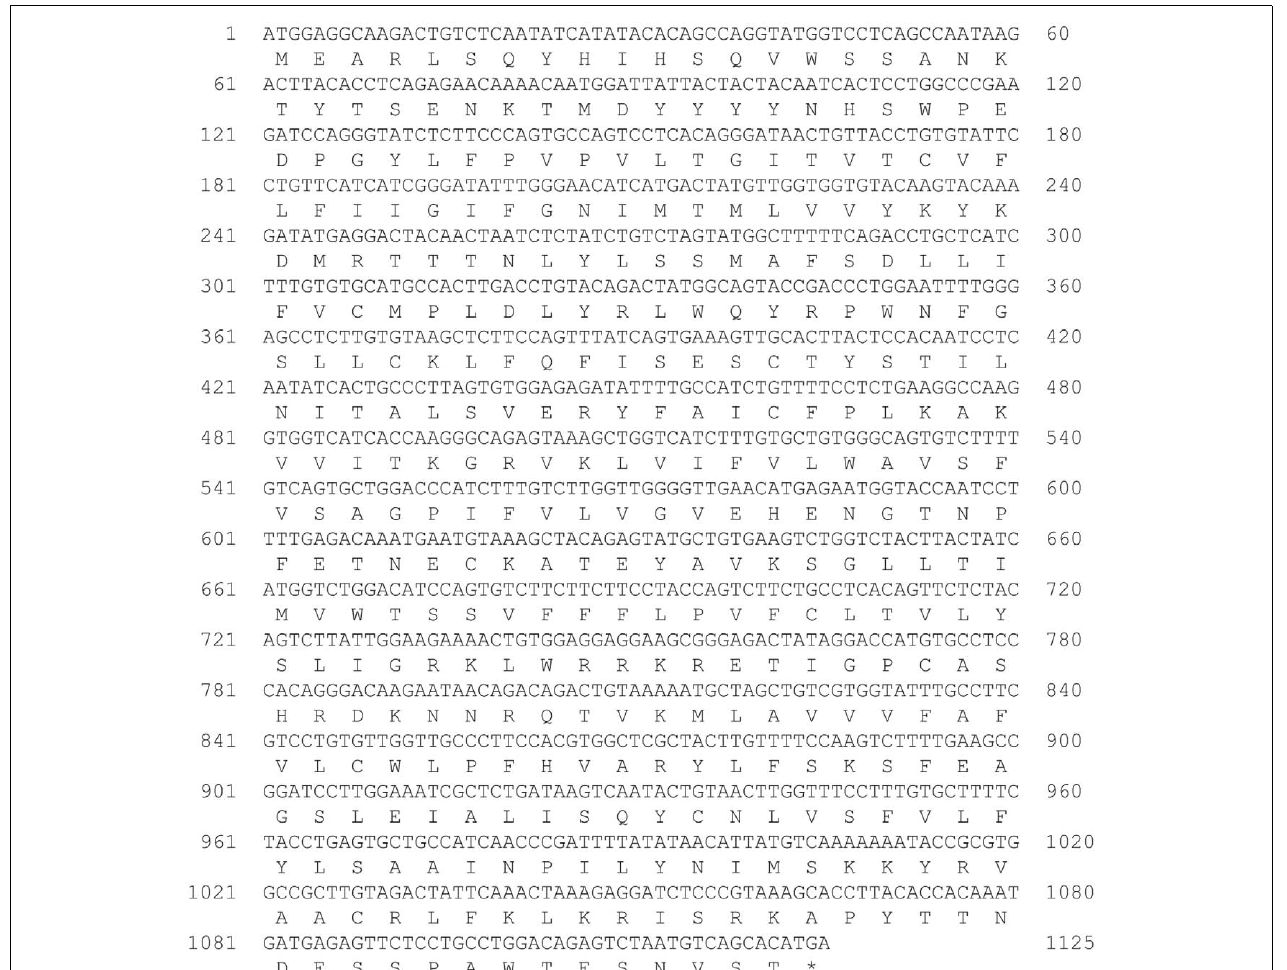
FIGURE 1 | Nucleotide and deduced amino acid sequences of growth hormone secretagogue-receptor (GHS-R) a-like receptor for bullfrog. Asterisk indicates the termination codon (TGA).